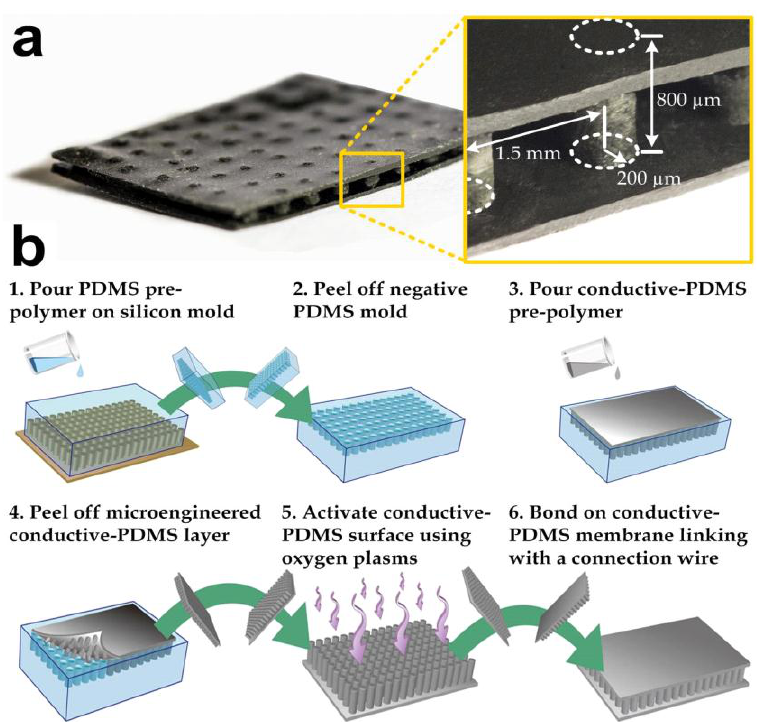
Figure 1. ( a ) Photograph of a microfabricated conductive-polydimethylsiloxane